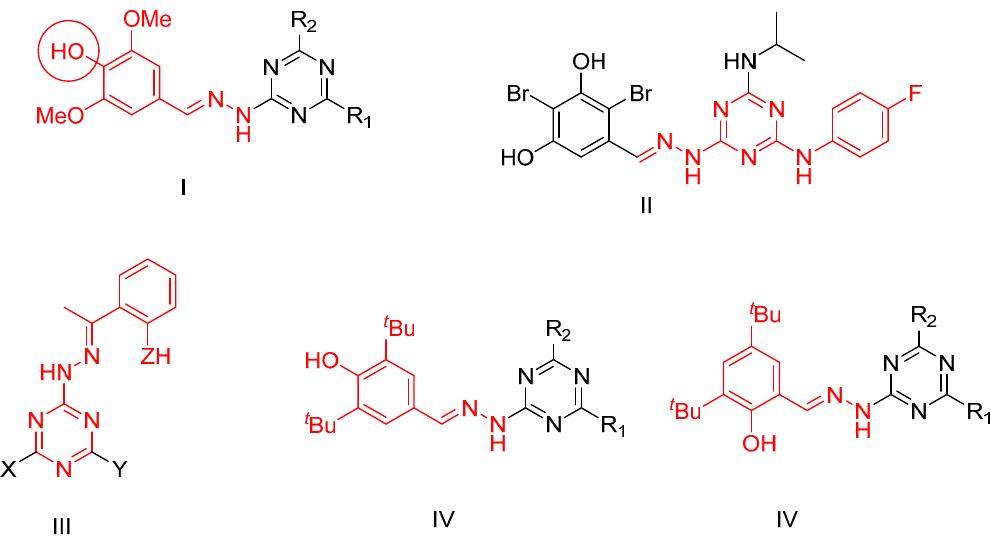
Figure 1. Structure of the s -triazine hydrazone derivative with potent anticancer activity.